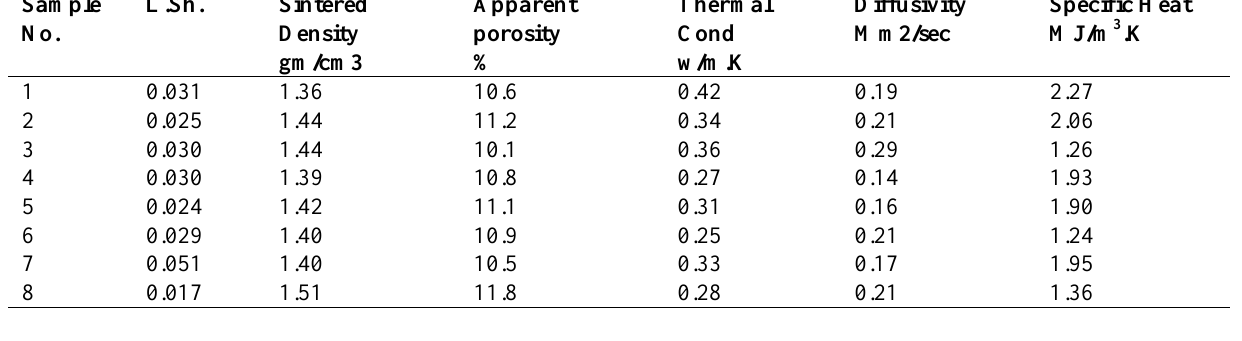
Specific Heat MJ/m 3 .K